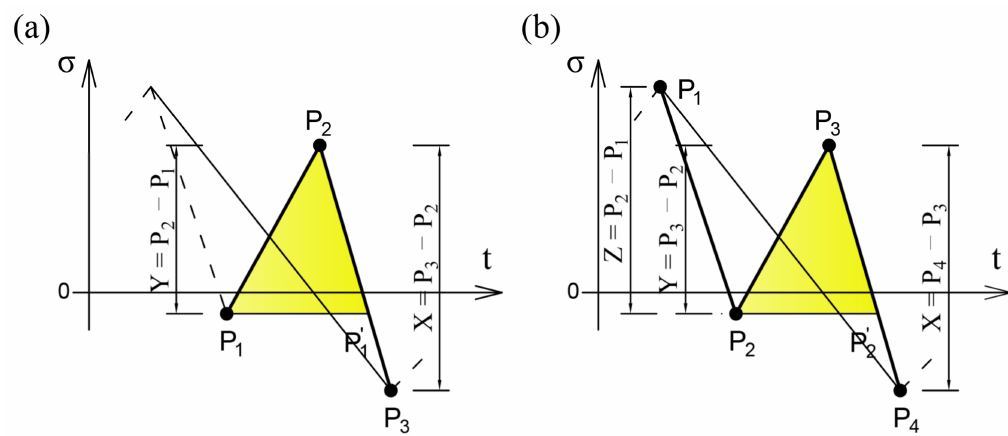
history and the extraction of full cycles from it, where the full cycle manifests as a